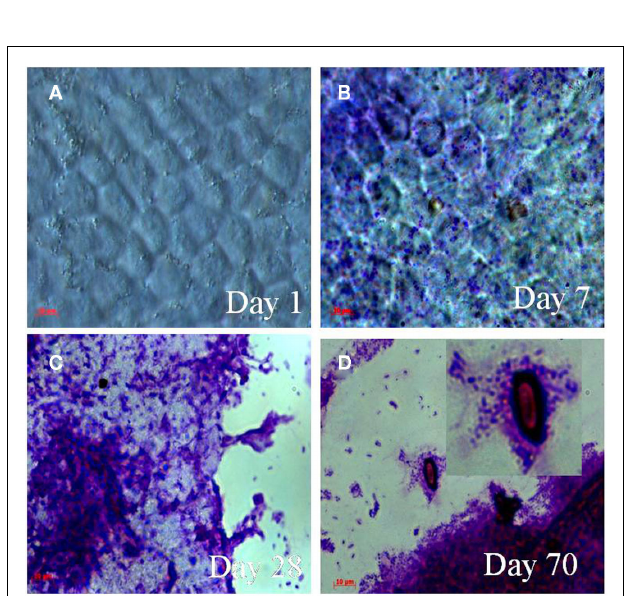
FIGURE 2 | Micrographs showing attachment and utilization of shrimp chitin by V. cholerae O1 in MW–CC microcosm. Samples were stained with 0.4% crystal violet.The stained samples were visualized using a light microscope (Carl Zeiss model Axioskop 40). Microscope images were captured digitally (AxioCam MRc) and processed using Adobe Photoshop (version 5). (A) Hexagonal structure of intact chitin chip at day 1 (B) attachment and colonization of the chitin chip by V. cholerae O1 cells at day 7; (C) aggregates of biofilm of V. cholerae O1 cells on decaying chitin chips at day 28; (D) thick biofilm and chitin residues colonized by V. cholerae O1 cells showing utilization of chitin (higher magnification in inset) at day 70. (Scale bars in red indicate 10 μ m).